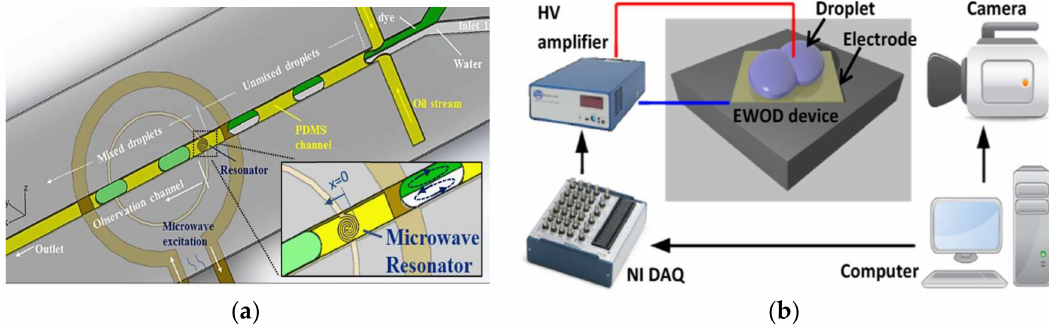
Figure 2. Droplet mixing in a microfluidic device ( a ) Mixing enhanced by adding a microwave heater: the heat induces non-uniform Marangoni stresses, leading to fast mixing, reprinted with permission from [25]. ( b ) Droplet mixing by alternating current (AC) electrowetting: the best mixing time was about 2% of the diffusive mixing time, reprinted with permission from [26].